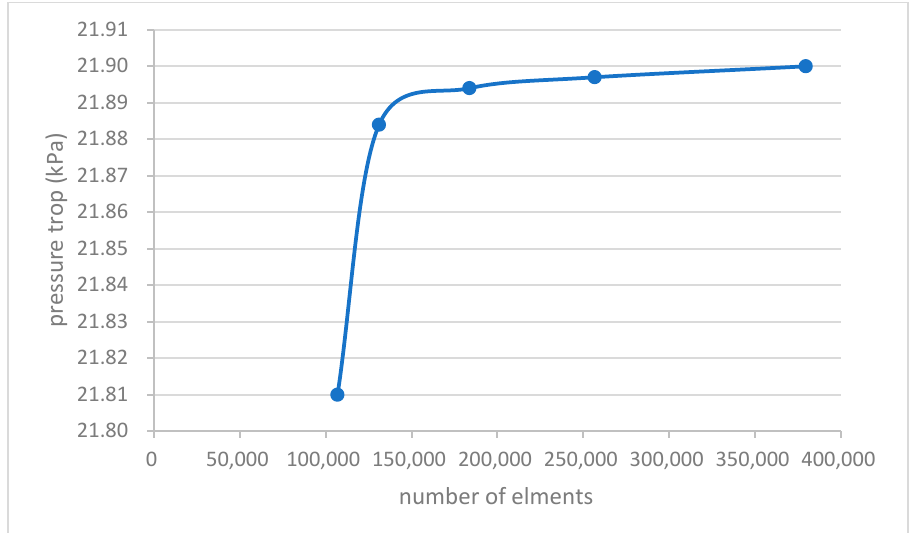
Figure 2. The pressure drop varies with the number of elements.